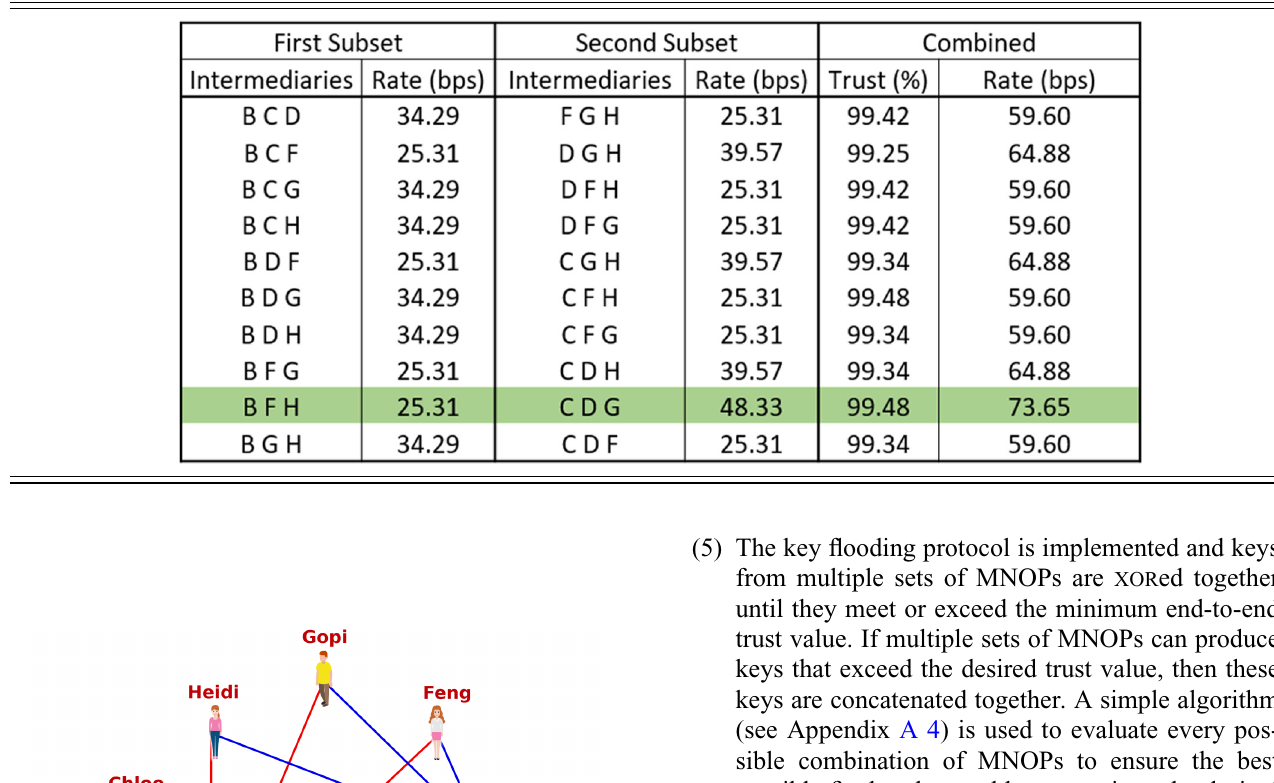
TABLE I. A table demonstrating the use of flooding to improve key rates and security in a realistic network scenario. Key rate data are taken from our eight-user fully connected quantum test bed and the trust values for the intermediary nodes from Fig. 10. All possible partitions of the six intermediary nodes that can simultaneously boost security and rate are shown. Of these, the row highlighted in green provides the best improvement to both security and end-to-end key rate. A and I will also combine their keys obtained via a direct link to further improve the throughput.